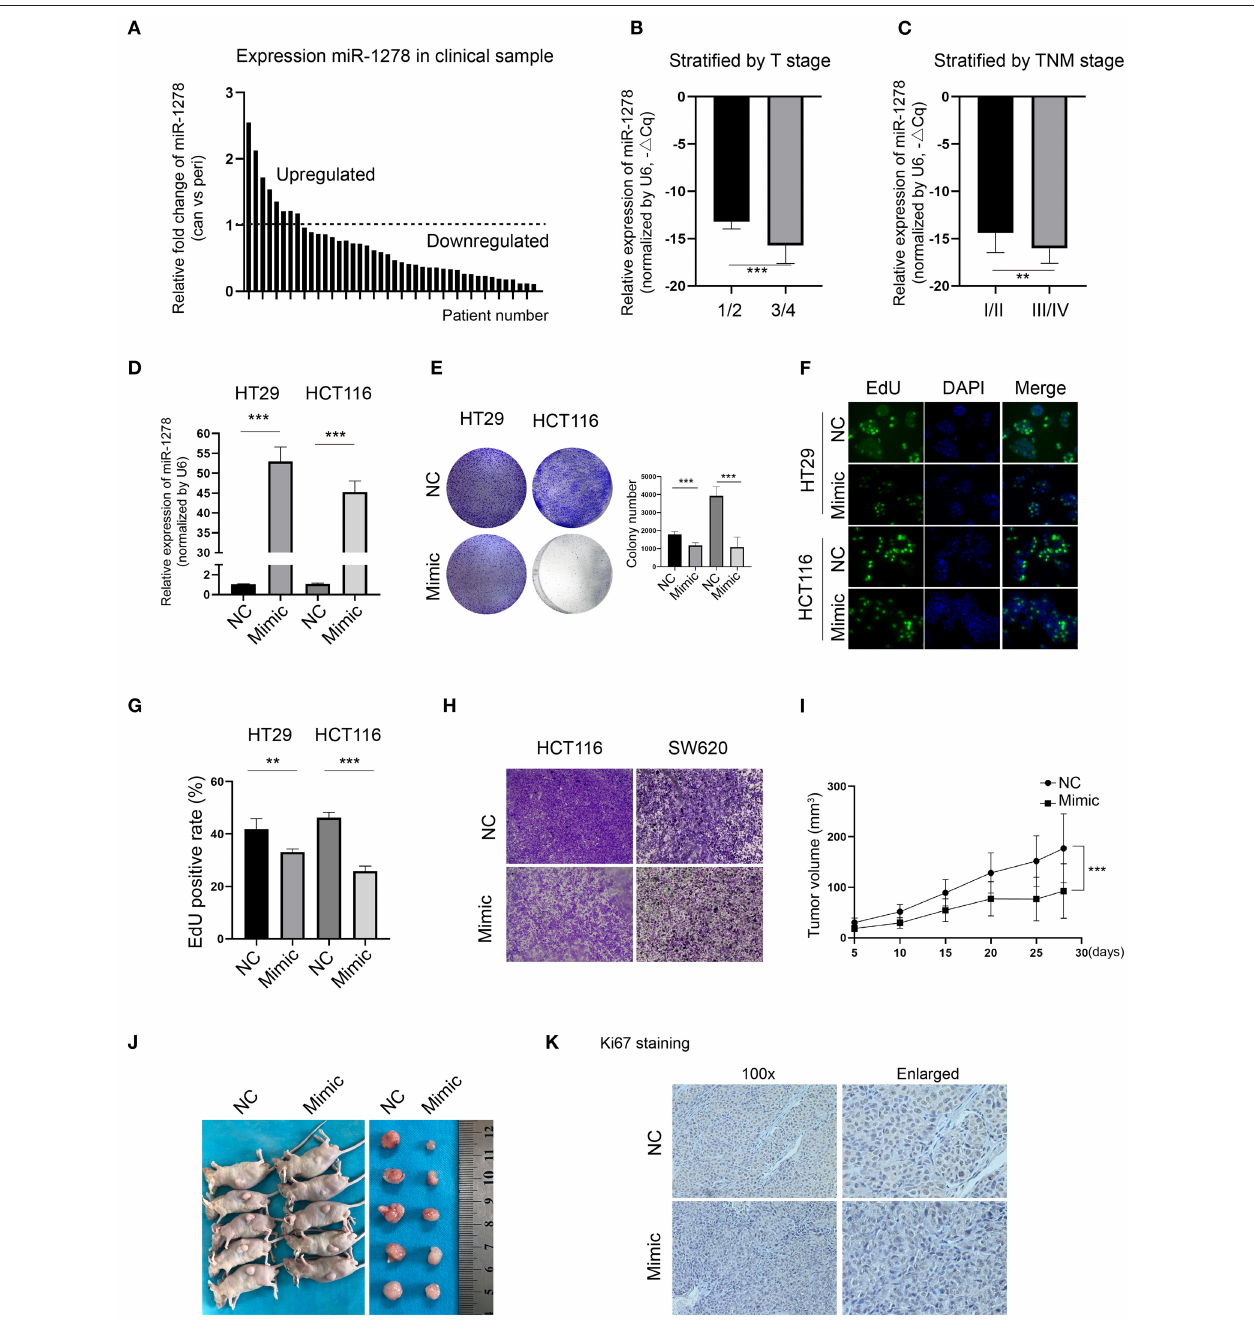
FIGURE 1 | miR-1278 is downregulated in CRC, and the miR-1278 mimic inhibits tumor growth in vitro and in vivo . (A) The expression of miR-1278 was determined in 42 pairs of CRC samples and the associated peritumoral tissues by qRT-PCR. miR-1278 was downregulated in 34 pairs, while it was upregulated in 8 pairs. (B,C) Relative expression of miR-1278 in CRC tissues compared to the reference gene. 1 Cq refers to the Cq of the target gene minus that of the reference gene; thus, – 1 Cq represents the miR-1278 expression level normalized to GAPDH. When stratified by T stage, high grade was associated with low expression of miR-1278. When stratified by TNM stage, high grade was correlated with low expression of miR-1278. (D) HT29 and HCT116 cells were transfected with the miR-1278 mimic and verified by qRT-PCR. (E) A colony formation assay was performed to determine the colony formation ability. Transfection of the miR-1278 mimic reduced colony formation in HT29 and HCT116 cells. (F,G) The EdU assay showed that transfection of the miR-1278 mimic significantly inhibited cell proliferation in HT29 and HCT116 cells. (H) Transwell assays showed that transfection of the miR-1278 mimic greatly impaired the migration of HCT116 and SW620 cells. (I) HCT116 cells transfected with miR-1278 or control were subcutaneously injected into nude mice followed by one injection at a 3-day interval. Tumor sizes were measured every 5 days. (J) After ∼ 4 weeks, mice were sacrificed, and tumors were collected. (K) IHC staining of Ki67 demonstrated that Ki67 was downregulated in the miR-1278 mimic group compared to the control group. NC, negative control; Mimic, miR-1278 mimic; ** P < 0.01, *** P < 0.001.